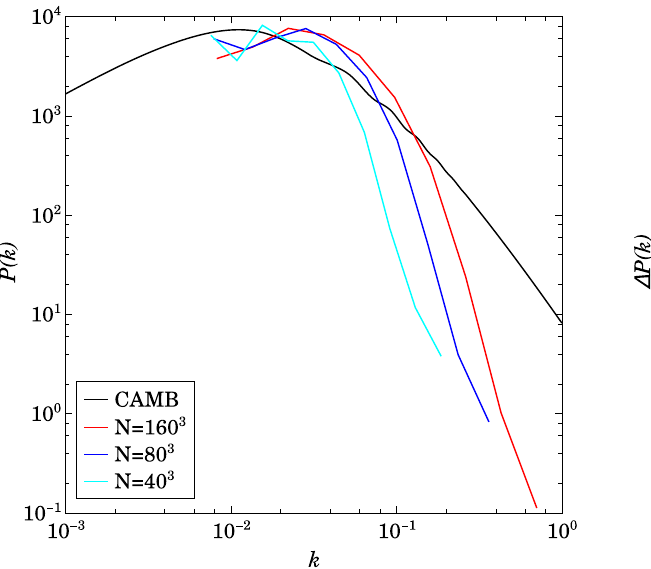
beginning of simulations, our initial data is derived from matter power spectrum at z + 1 = 1090, we ignore the dark energy in our simula- tions at the late time. So the black curve has a different trend with color ones in the left plot. The red, blue and cyan curves in the right plot explicitly show the suppression of matter power spectra for modes with wave number similar to the tensor perturbations’ at 160 3 , 80 3 and 40 3 resolution respectively. And this suppression converge to about 0 .